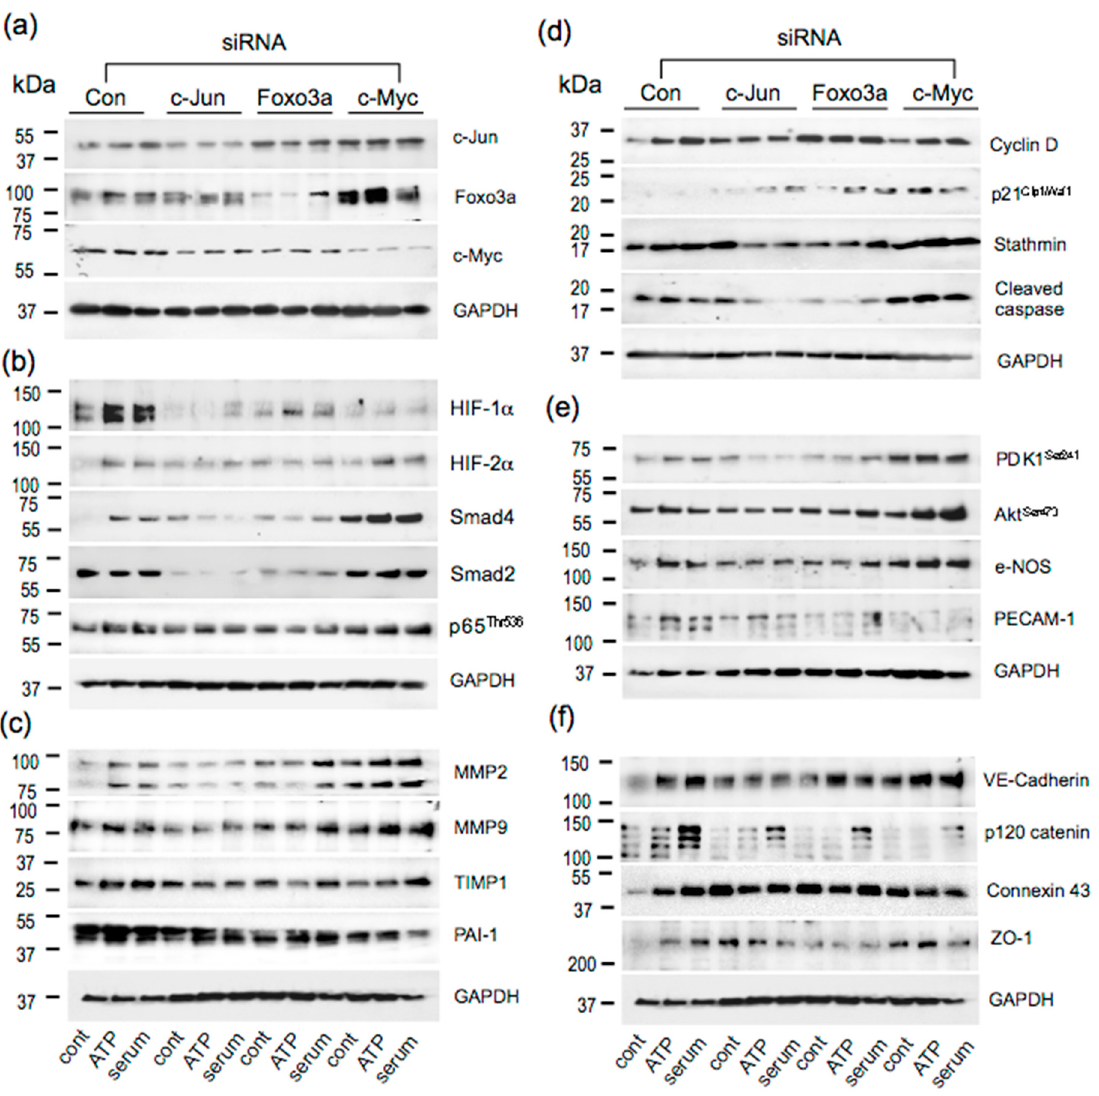
Figure A1. E ff ect of c-Jun, Foxo3a, and c-Myc KD on the expression of angiogenesis associated proteins. VVECs were transfected with scrambled siRNA or siRNA to c-Jun, Foxo3a, and c-Myc siRNA. Cells were stimulated with ATP (100 µ M, 24 h), serum (1% FBS in DMEM, 24 h) or remained untreated. Total cell lysates were subjected to Western blot analysis. Shown are representative data from three to four (n = 3–4) independent experiments on three cell populations.